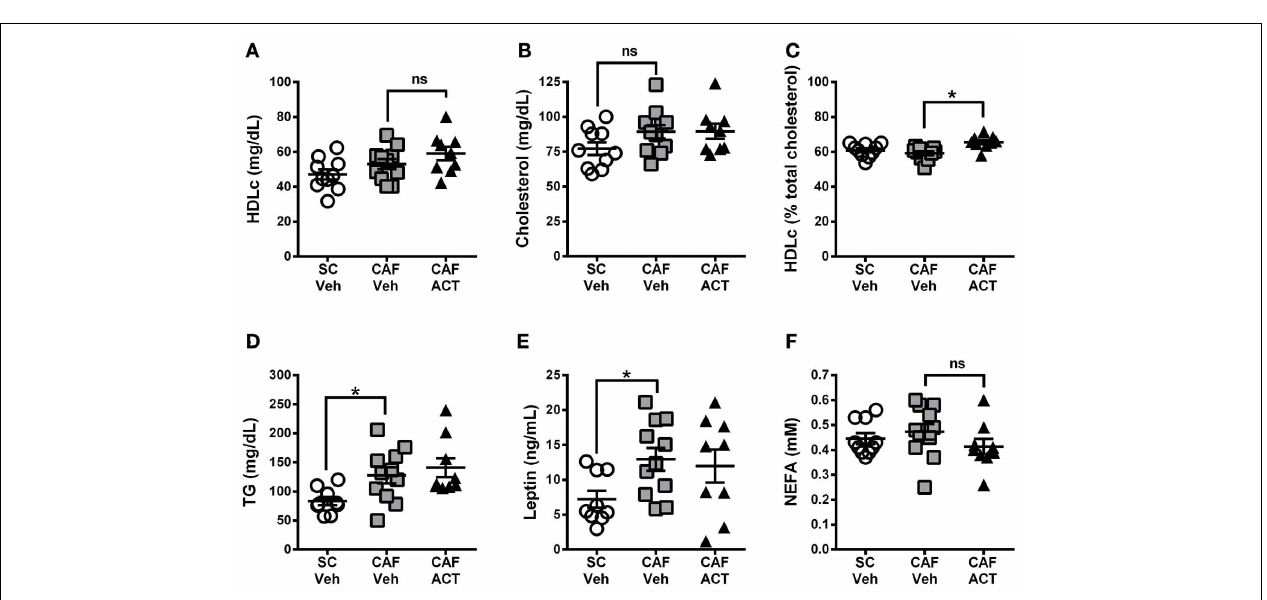
percentage. (E) Mass of intrascapular brown adipose tissue (iBAT). Mean ± s.e.m. ( n = 9–11 per group). ∗ p < 0 . 05 by t -test. No statistical difference was revealed between the CAF-ACT and the CAF-Veh group. ( SC , standard chow; CAF , cafeteria diet; Veh , vehicle; ACT , ACT-335827; ns , not significant).